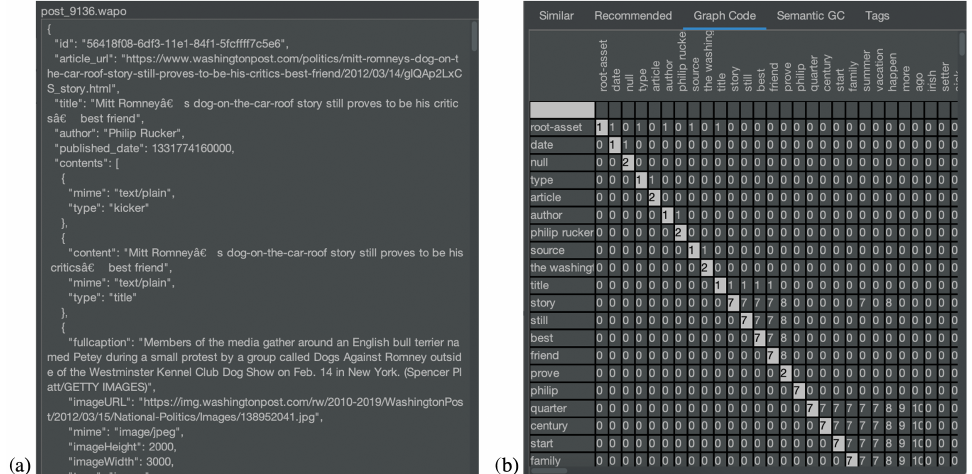
Figure 13. Washington Post article ( a ) and the corresponding graph code ( b ).